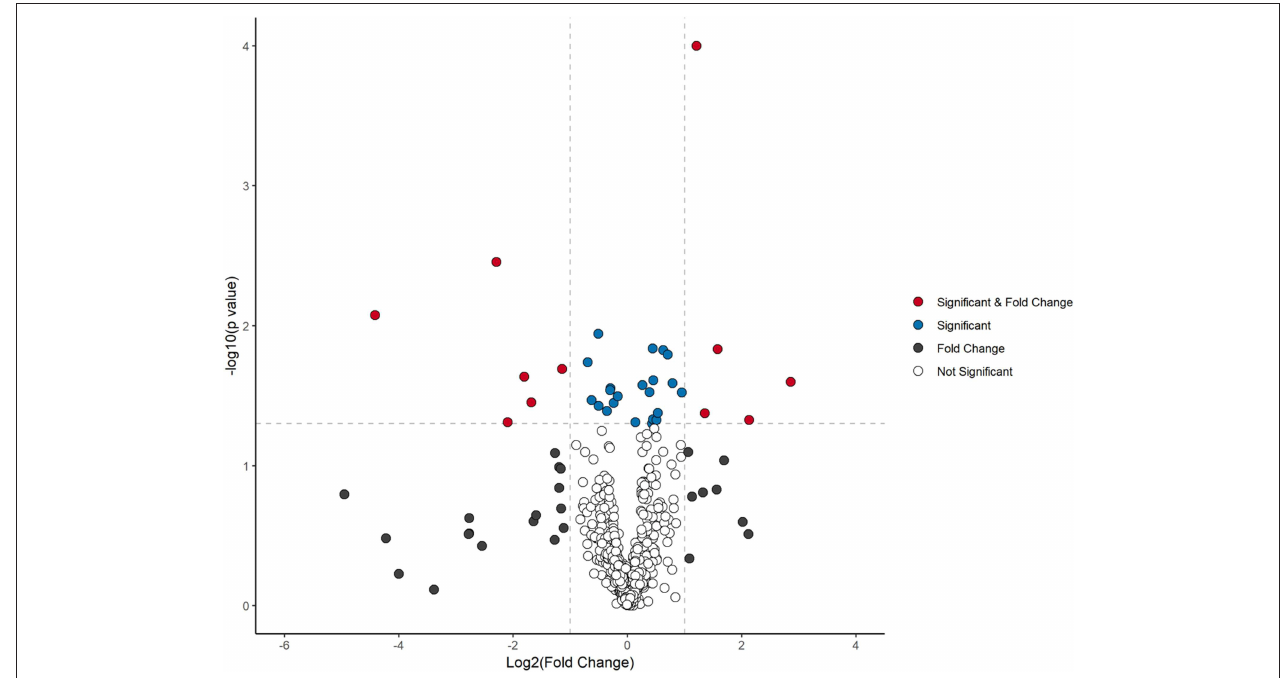
FIGURE 1 | Volcano plot analysis of metabolite changes after 10 weeks dietary intervention. Red dots denote significant ( p < 0.05) and fold change ( > 1.2) features. Blue dots represent significant features ( p < 0.05), black dots designate fold change ( > 1.2), and clear dots represent neither no significance ( p > 0.05) or fold change of <